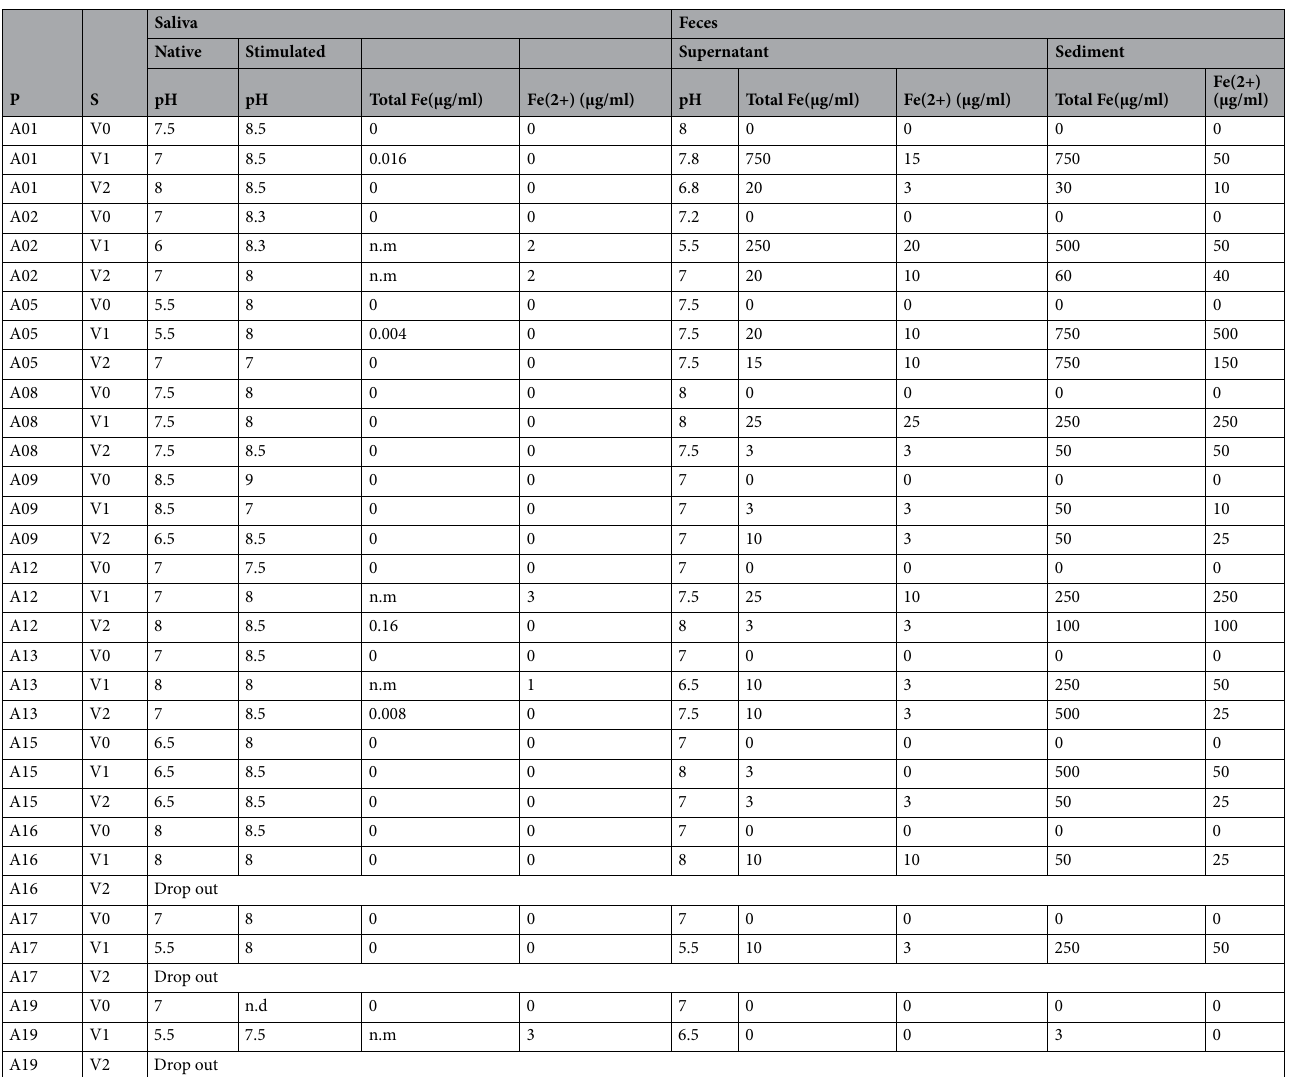
Table 2. Changes in pH and iron content at baseline t0, as well as t1 (one week) and t2 (four weeks) of SFOH administration. P: patient number, S: time-point (t0, t1, t2) related sample number (V0, V1, V2), n.d. not determined, at V0, the patient did not produce any additional saliva after stimulation. n.m. not measurable: at low concentrations, Fe test kits showed diffuse colors or discrepancies and these cases were excluded as not